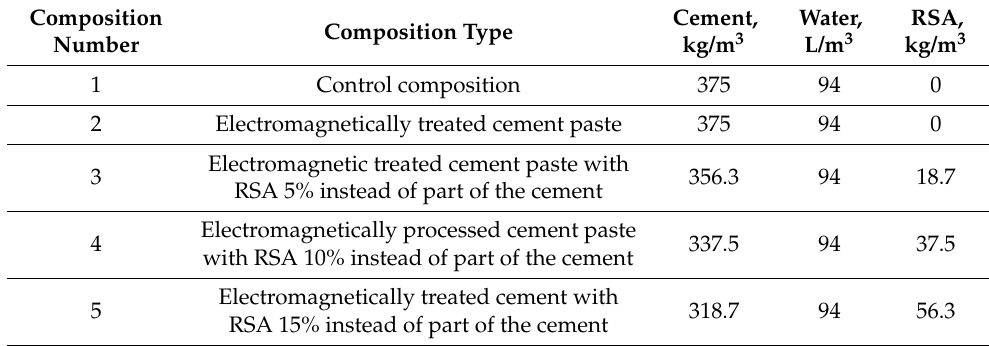
Figure 3. Rice straw biochar ( a ) appearance; ( b ) microstructure with a resolution of 1 nm [54]. Table 6 and Figure 2 show that electromagnetic activation changes the chemical composition of rice straw biochar: for example, the proportion of C increased by 35.2%. Table 6. Compositions of concrete mixes.